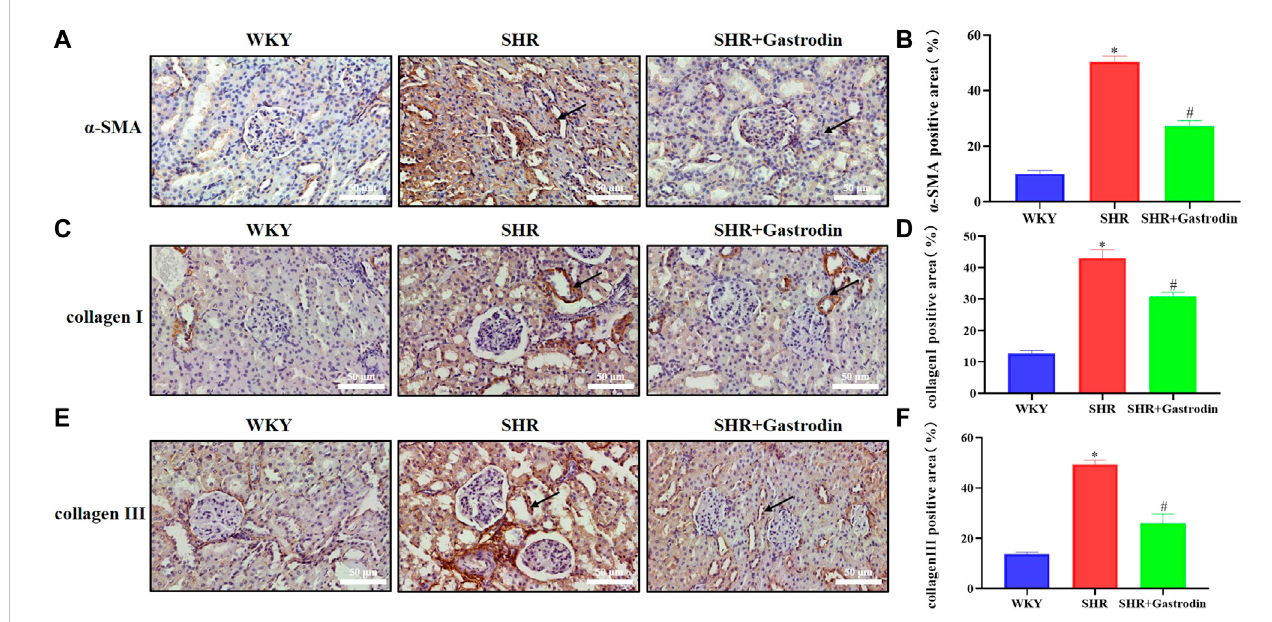
FIGURE 2 Gastrodin reduced the expressions of fi brosis markers in spontaneously hypertensive rats (SHRs) (A) Immunohistochemistry (IHC) was performed to measure the levels of α -smooth muscle actin ( α -SMA) in the renal tissues of rats. The positive area in (B) α -SMA staining cells in rats was calculated. IHC was performed to detect the expressions of (C) collagen I and the positive area in (D) collagen I staining cells in rats was calculated in the renal tissues. IHC was performed to detect the expressions of (E) collagen III and the positive area in (F) collagen III staining cells in rats was calculated in the renal tissues.All micrographs were taken at ×400 magni fi cation. Scale bar = 50 μ m. All values are mean ± SD ( n = 5 for each group). * p < 0.05 vs the WKY group, # p < 0.05 vs the SHR